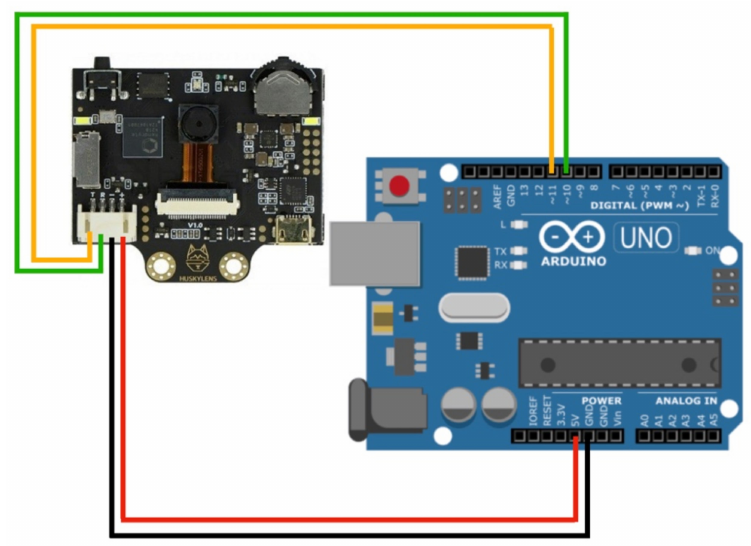
Figure 4. Circuit connections diagram for the Huskylens facial recognition camera.